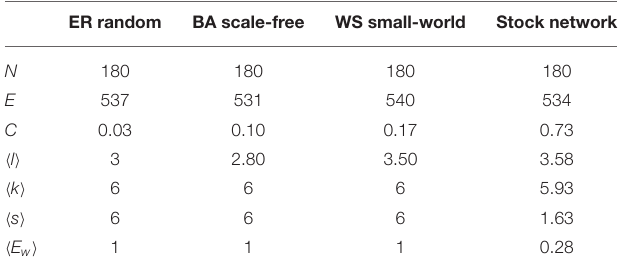
TABLE 1 | Statistical description of the ER random, BA scale-free, and WS small-world networks and the stock network. ER